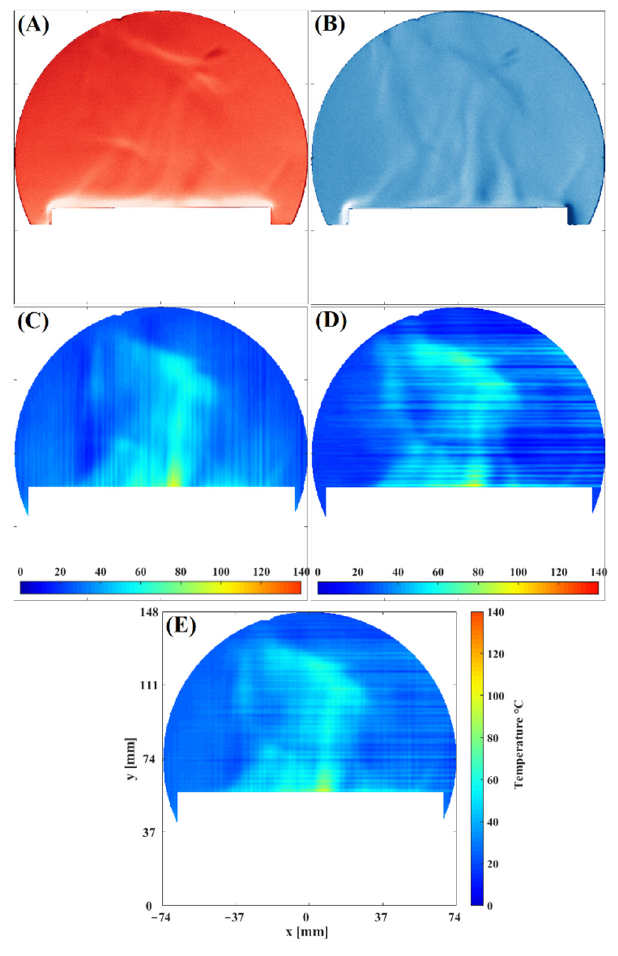
Figure 5. An instantaneous temperature field of the convective fluid flow generated by the plate. ( A ) vertical sensitivity Schlieren image, ( B ) horizontal sensitivity Schlieren image, ( C ) Temperature field of ( A ), ( D ) Temperature field of ( B ), ( E ) Combination of temperature field of ( C , D ).